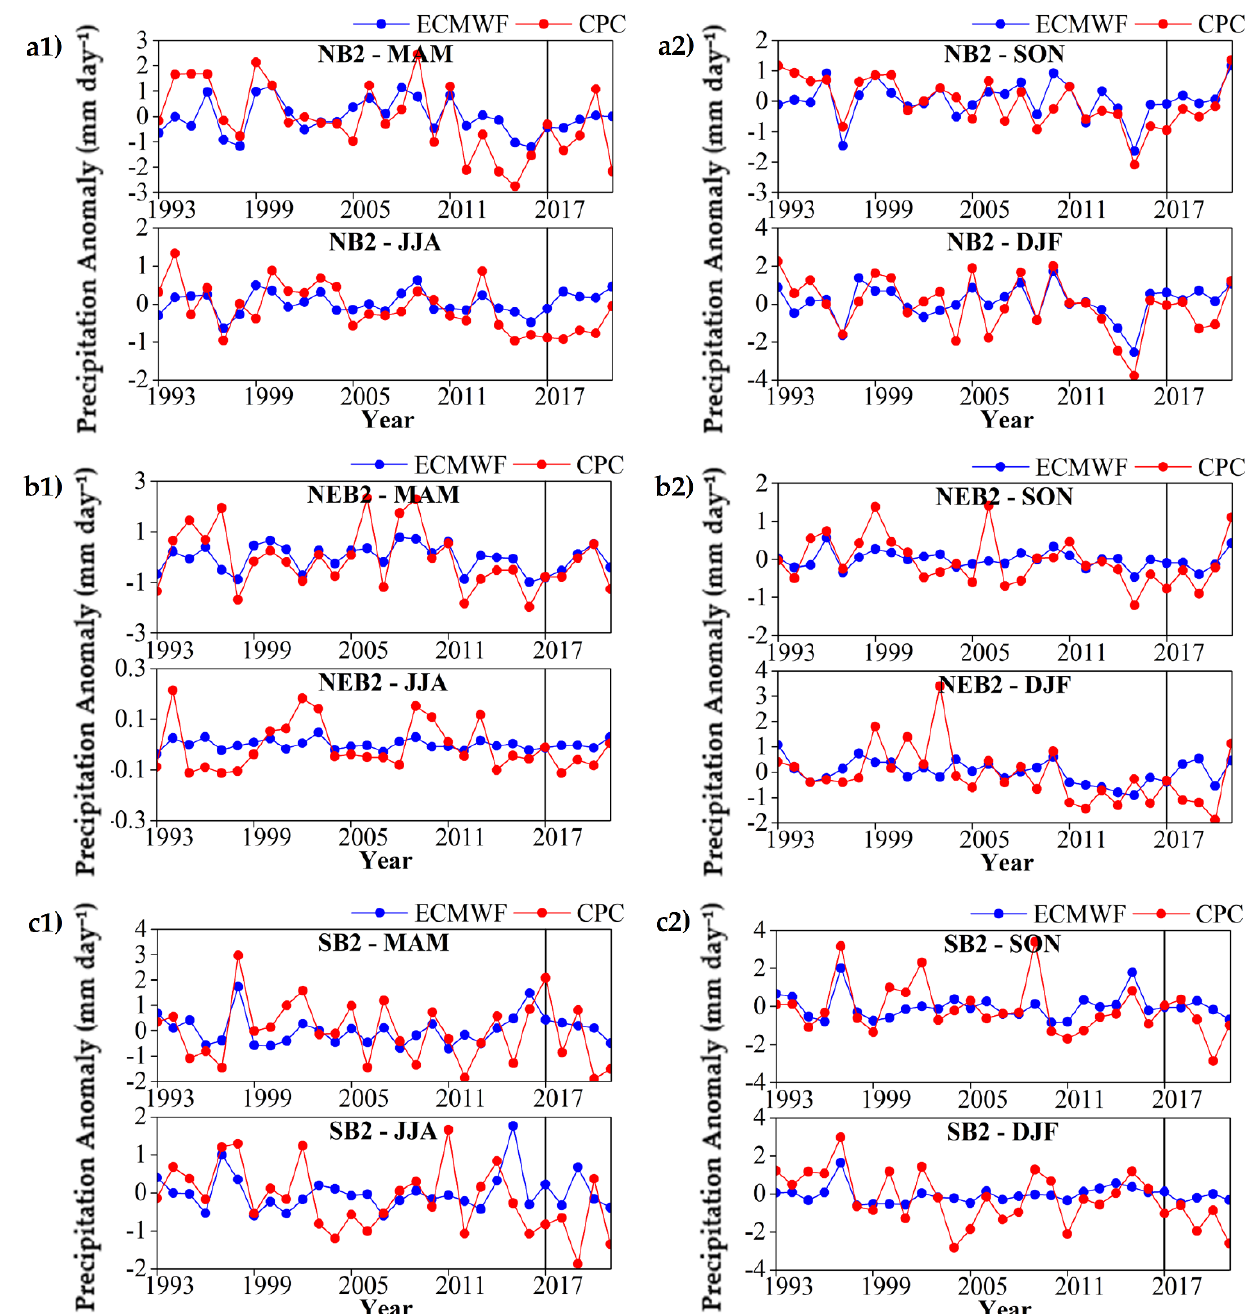
Figure 8. Average seasonal precipitation anomalies (mm day − 1 ) in the NB2 ( a ), NEB2 ( b ), and SB2 ( c ) subdomains from 1993 to 2021. The vertical black line indicates the hindcasts’ end and forecasts’ start.